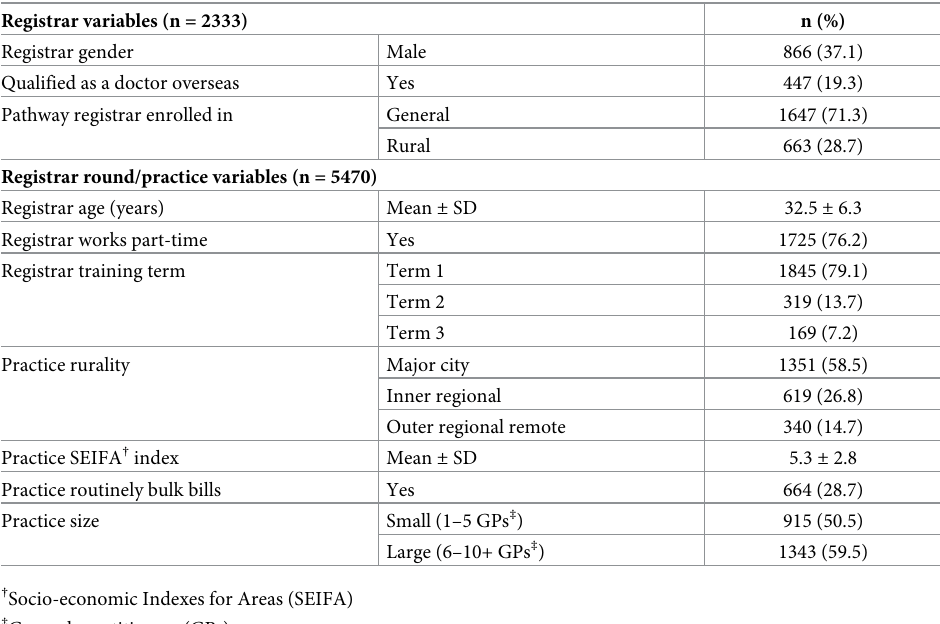
Table 1. Demographics of participating GP registrars and their